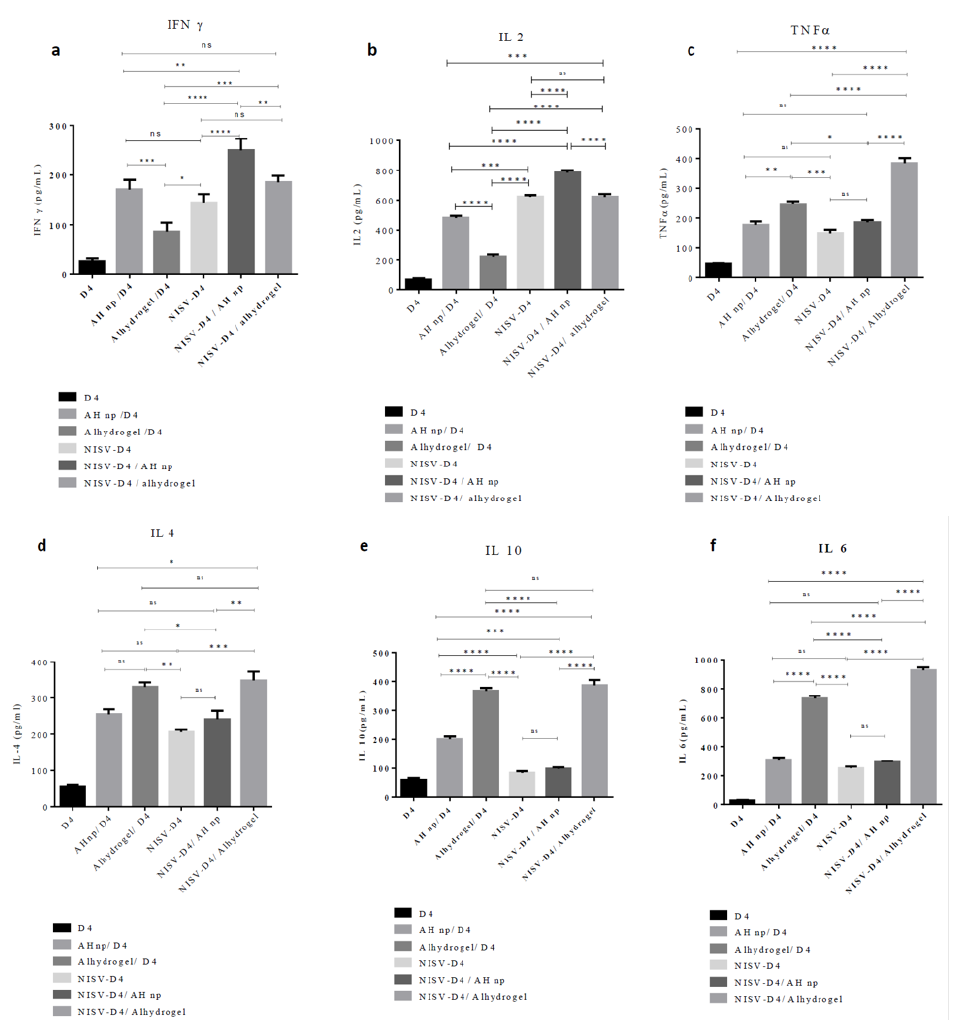
Figure 4. Immunisation with NISV-D4/AH np elicits a mixed Th1/Th2 immune response. Evaluation of cytokine (a) IFN-γ, (b) IL-2, (c) TNF-α, and (d) IL-4, (e) IL-10, and (f) IL-6 from splenocyte culture supernatant post immunisation and stimulated in vitro with D4 or media only for 48 h. Error bars represent ± SD of three experiments. Statistically significant change between immunised groups were calculated using two-way ANOVA followed by Tukey’s multiple comparisons test * p < 0.05, ** p < 0.01, *** p < 0.001, **** p < 0.0001, ns: non-significant.